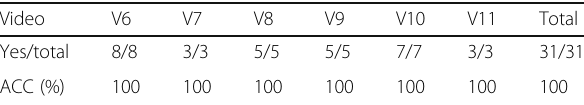
Table 2 Recognition result that whether the type of goal score in the basketball video is a free throw